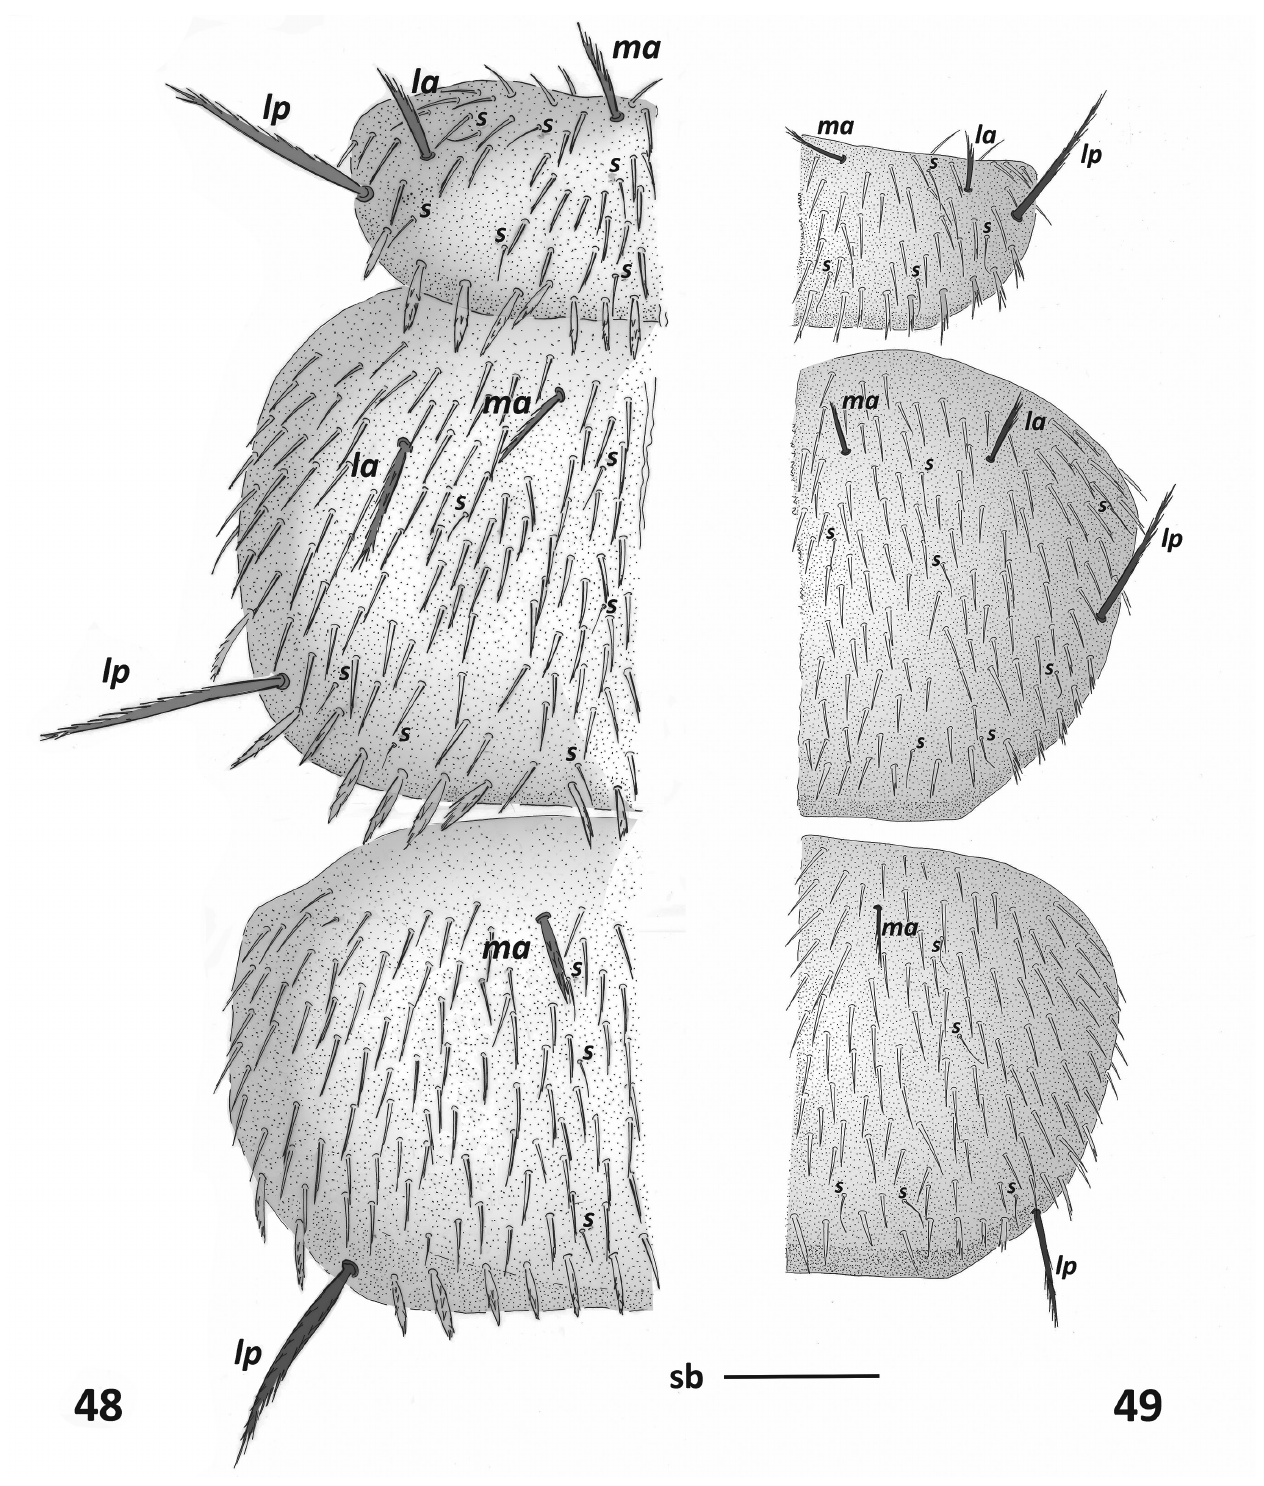
Figs 48–49. – 48 . Campodea ( Campodea ) rhopalota Denis, 1930, ♂, 4.0 mm, from Geneva, Switzerland, pronotum, mesonotum and metanotum. – 49 . Campodea ( Campodea ) silvestrii Bagnall, 1918, ♀, 2.9 mm, from Greece, pronotum, mesonotum and metanotum. Abbreviations: see Material and methods. Scale bar: 0.1